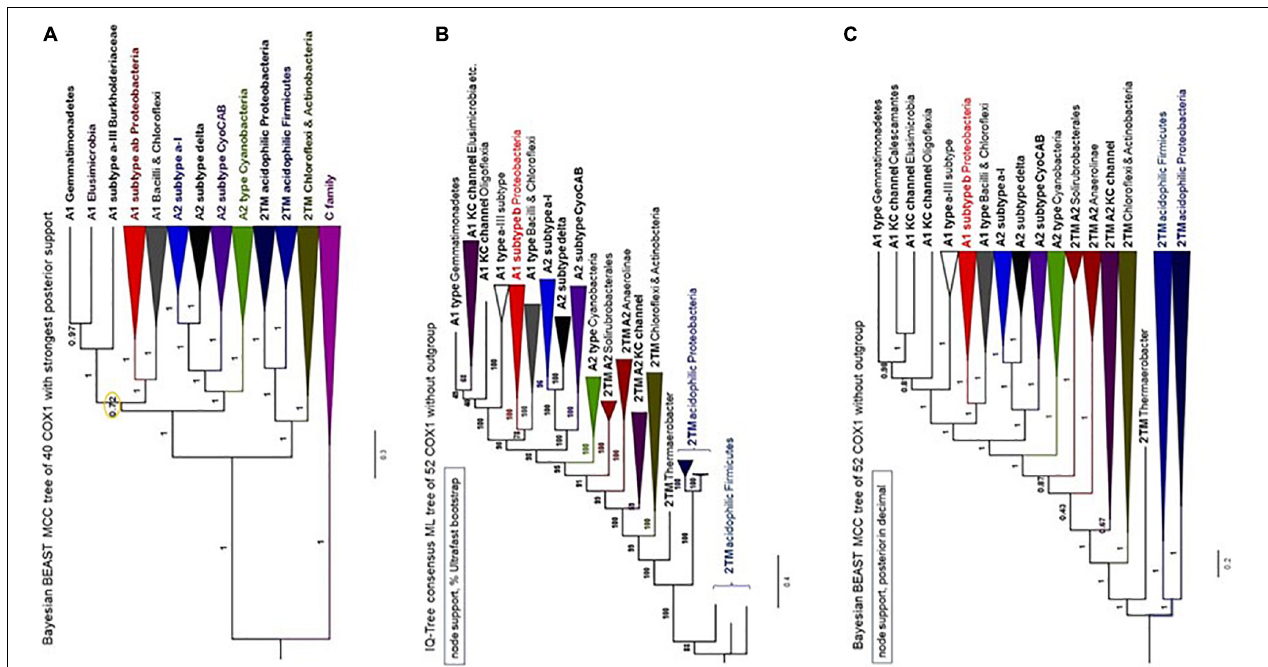
FIGURE 7 | Phylogeny of COX1 with and without family C outgroup. The illustration combines phylogenetic trees of COX1 obtained with similar alignments of COX1 sequences for a total of 647 amino acid sites. (A) MCC tree obtained with the BEAST program using a chain of 2 million iterations and the BLOSUM62 model applied to an alignment of 37 COX1 and three FixN protein sequences that was refined with the new approach presented in the Supplementary Material (in particular, Supplementary Figures 11, 12 ). The node indicated with the orange circle is the only one with posterior support below 0.97 (i.e., less than 97%) and was implemented from the tree shown in the related Supplementary Figure 12a . (B,C) Phylogenetic trees obtained with the IQ-Tree program in Panel B and the BEAST program in Panel (C) using the same WAG model as in Panel (A) and an alignment of 52 COX1 sequences without FixN paralogs as outgroup. The programs and node support systems are presented on the top left of each panel. Additional trees obtained with other programs and the same alignment (available upon request) are shown in Supplementary Figures 12a,c . The Bayesian tree in Panel (C) was re-rooted to the branch of acidophilic